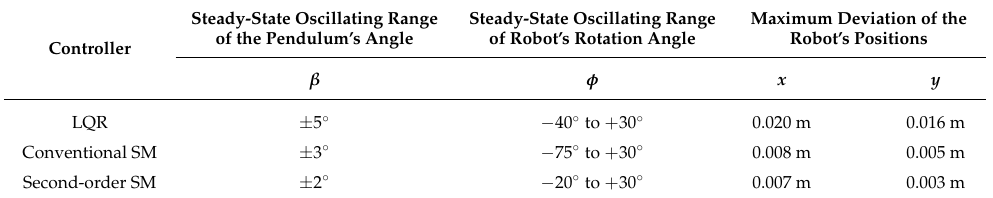
Table 3. The experimental results of the steady-state oscillating range of the pendulum’s angle, the steady-state oscillating range of robot’s rotation angle, and the maximum deviation of the robot’s positions.